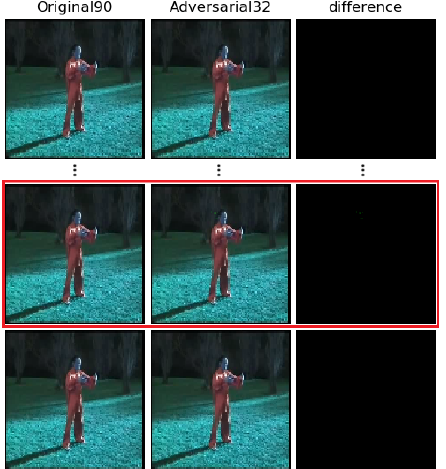
Figure 4. Other examples of adversarial frames generated by our algorithm in white-box adversarial attack. The clean video ( left ) can be classified correctly. The adversarial video ( middle ) with only one disturbed frame is misclassified, and the difference is shown as ( right ). The label 90 is “TaiChi”, while the label 32 is ‘GolfSwing’. The red square is the perturbed frame of that